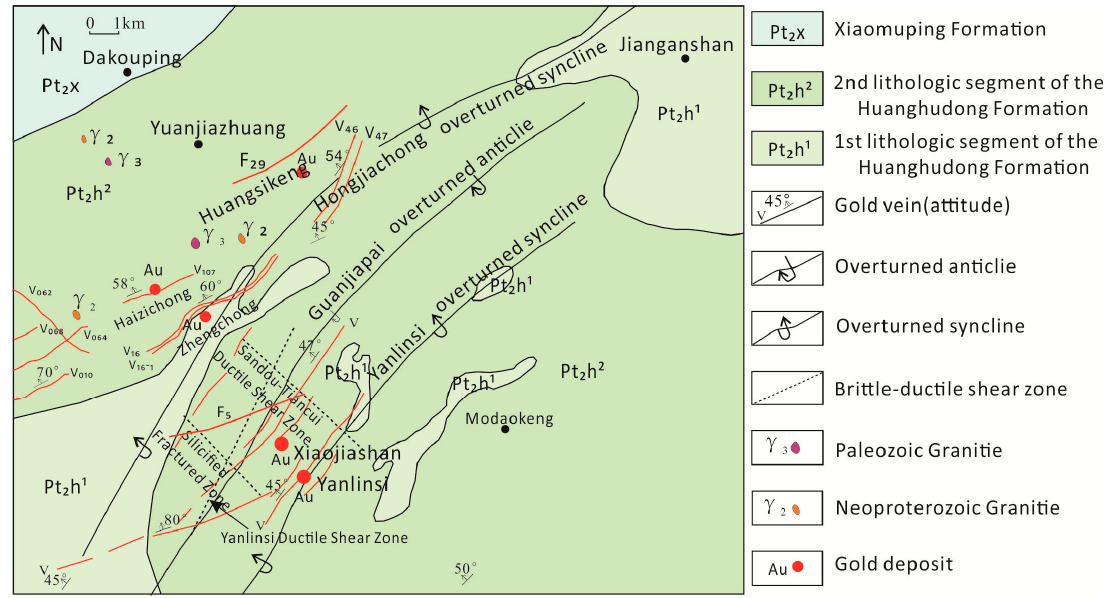
Figure 2. Schematic geological map of the Xiaojiashan deposit.